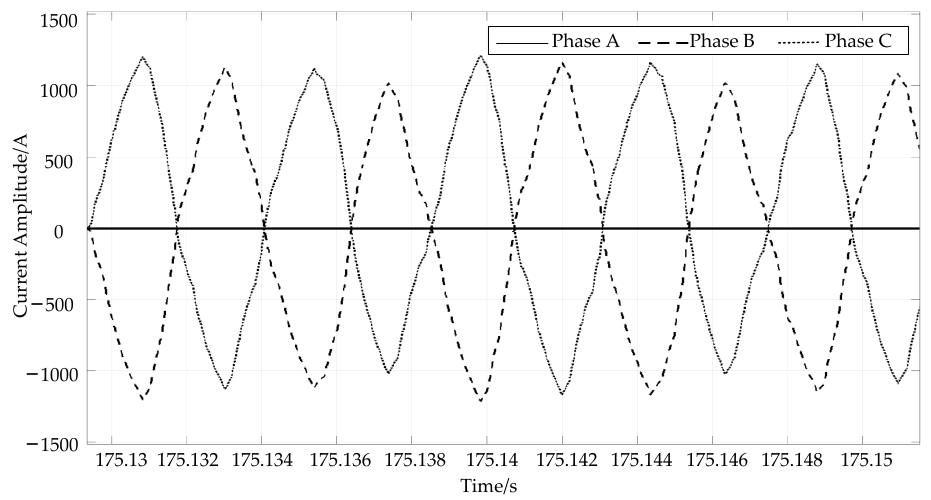
Figure 23. Stator current in the case of single-phase disconnection.